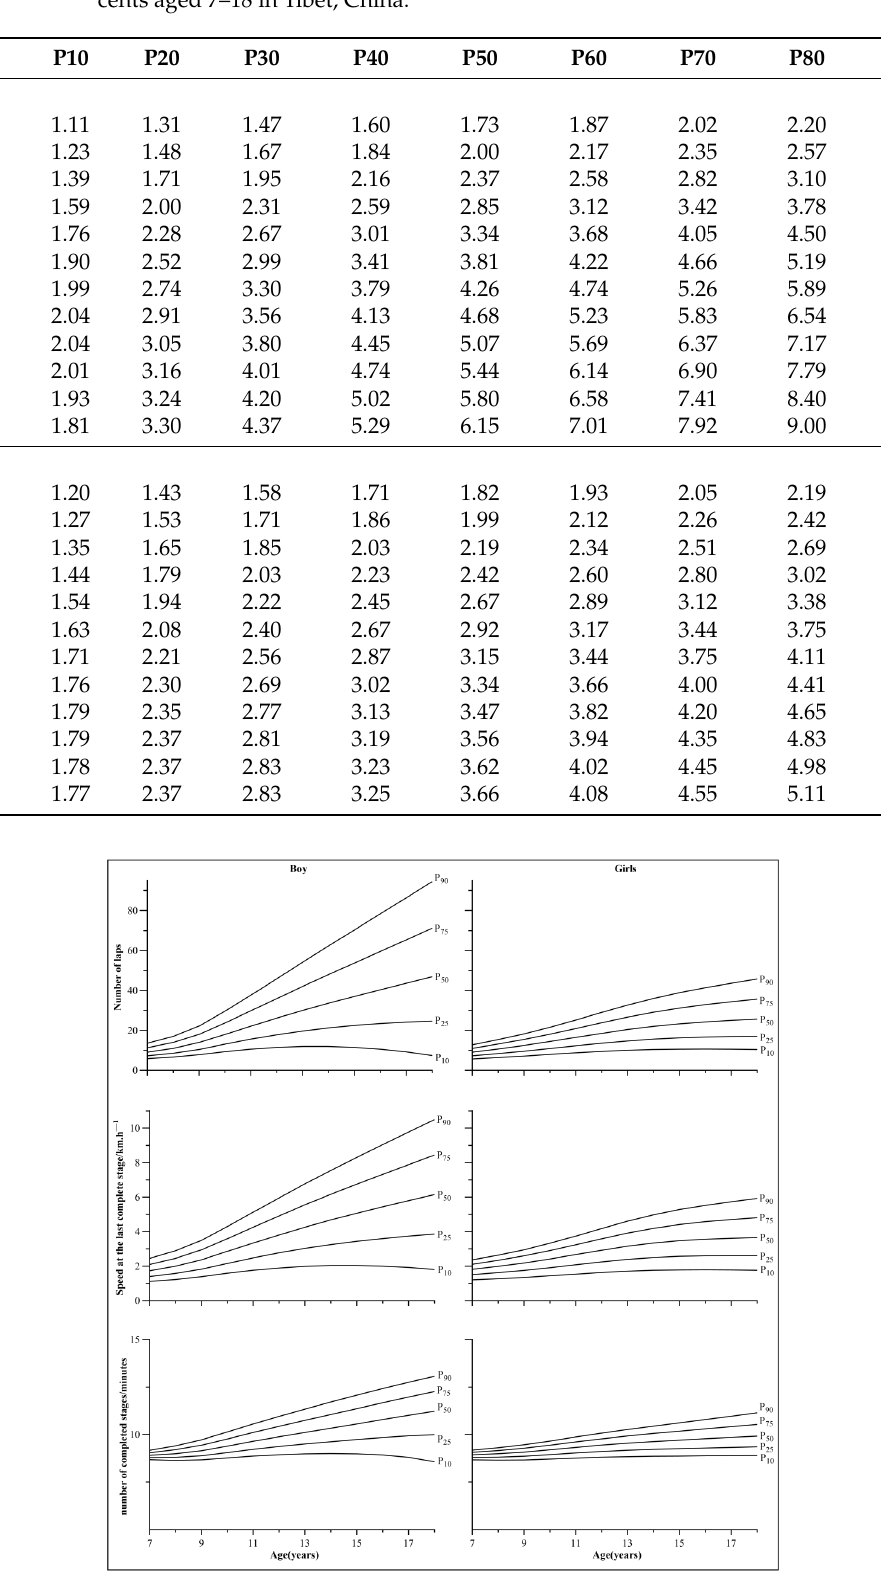
Figure 1. Smoothed centile curves (P10, P25, P50, P75, and P90) of the 20mSRT performance for Chinese Tibetan children and adolescents aged 7 – 18 in Tibet, China.